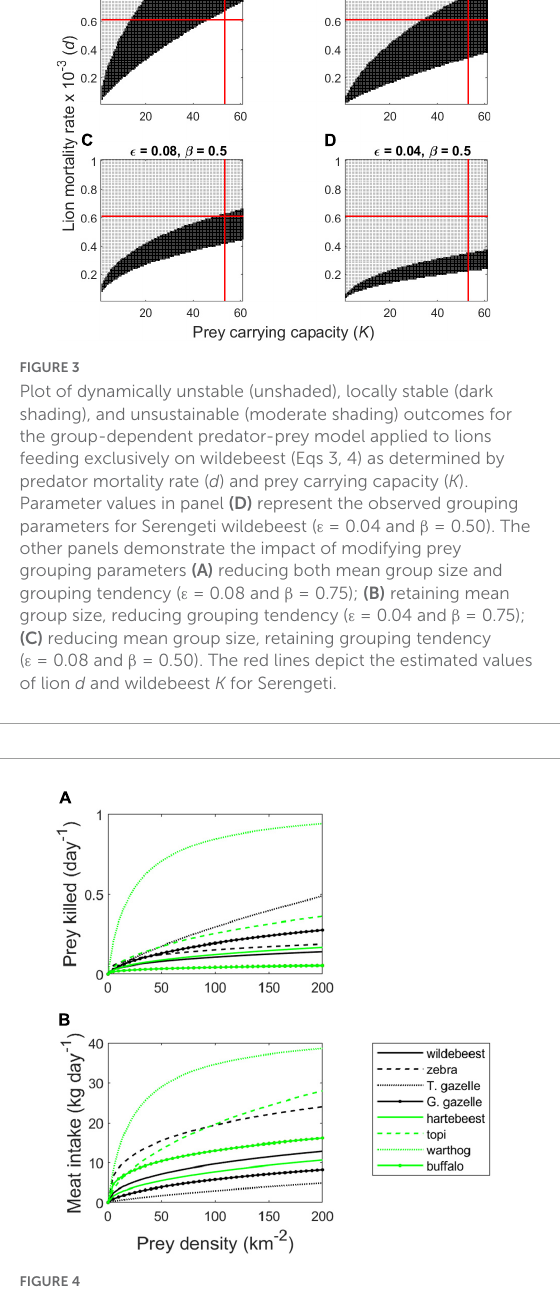
equivalent meat yield (and consequently an equivalent per capita rate of lion population growth) as ∼ 20 hartebeest per km 2